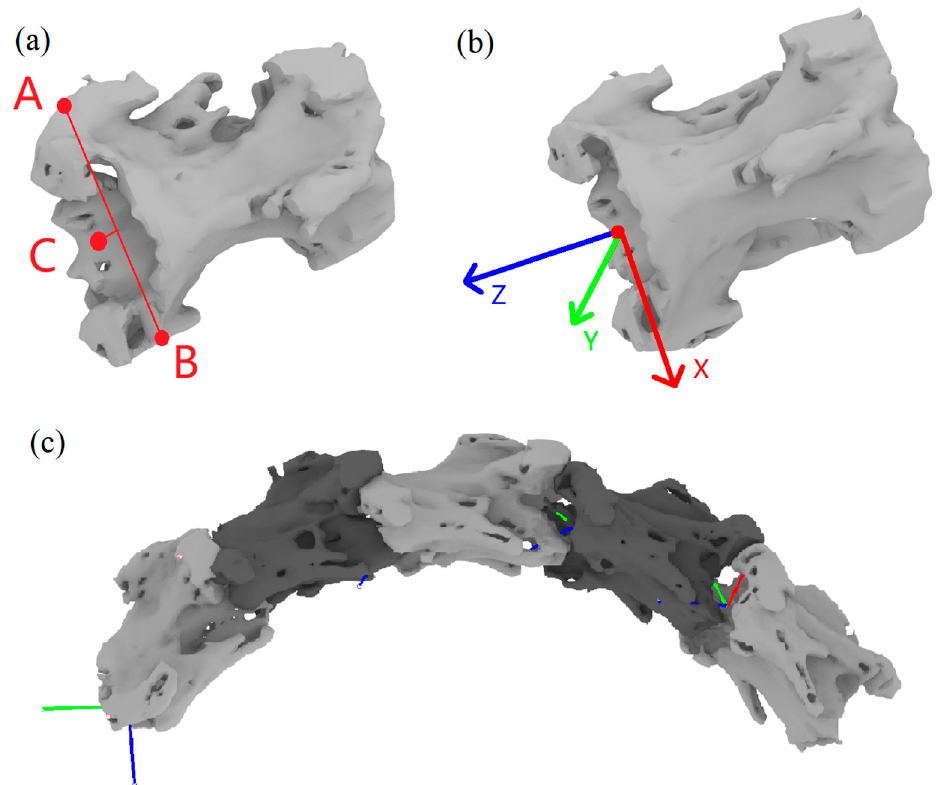
Figure 1. C4–C8 cervical spine modeling and coordinate system establishment: ( a ) Positioning points and auxiliary lines of the vertebrae: A/B—the most lateral point on the two anterior articular processes, C—the ventral midline point of the vertebral foramen on the cranially terminated articular surface of the vertebra; ( b ) diagram of vertebral coordinate system; ( c ) vertebrae combination diagram.